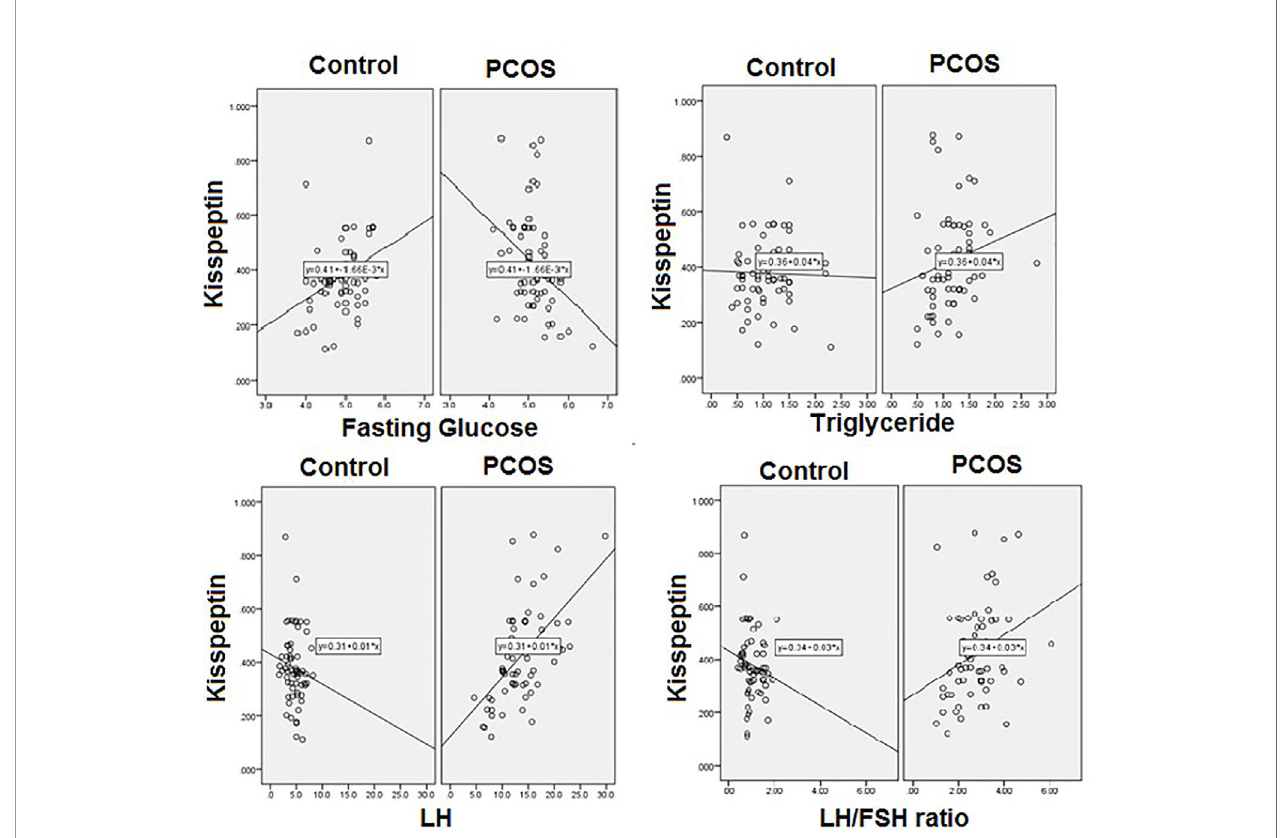
FIGURE 2 | Correlation between kisspeptin and glucose, triglycerides, LH, LH/FSH